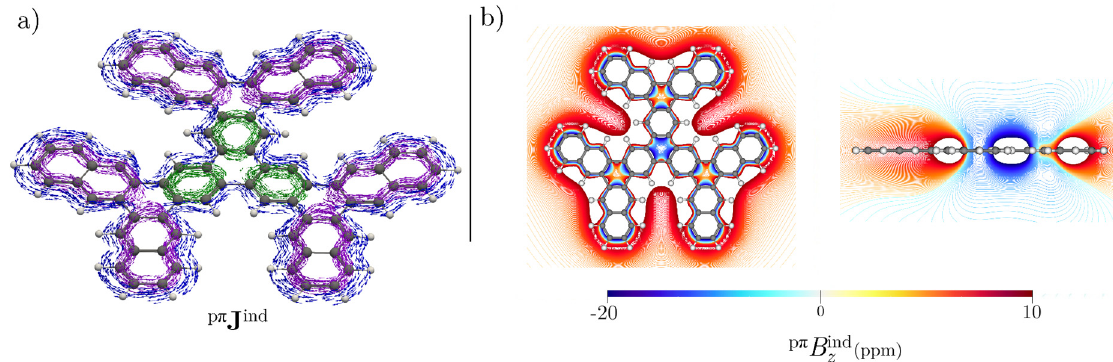
Figure 8. ( a ) p π J ind vector maps showing the diatropic peripheral ring current (in blue), naphthalene-like ring currents (in purple), and local 6-MR currents (in green) of [19]dendriphene. ( b ) Isolines of p π B ind z calculated in the transverse plane (left) and the molecular plane (right) of [19]dendriphene (scale conventions as in Figure 2).